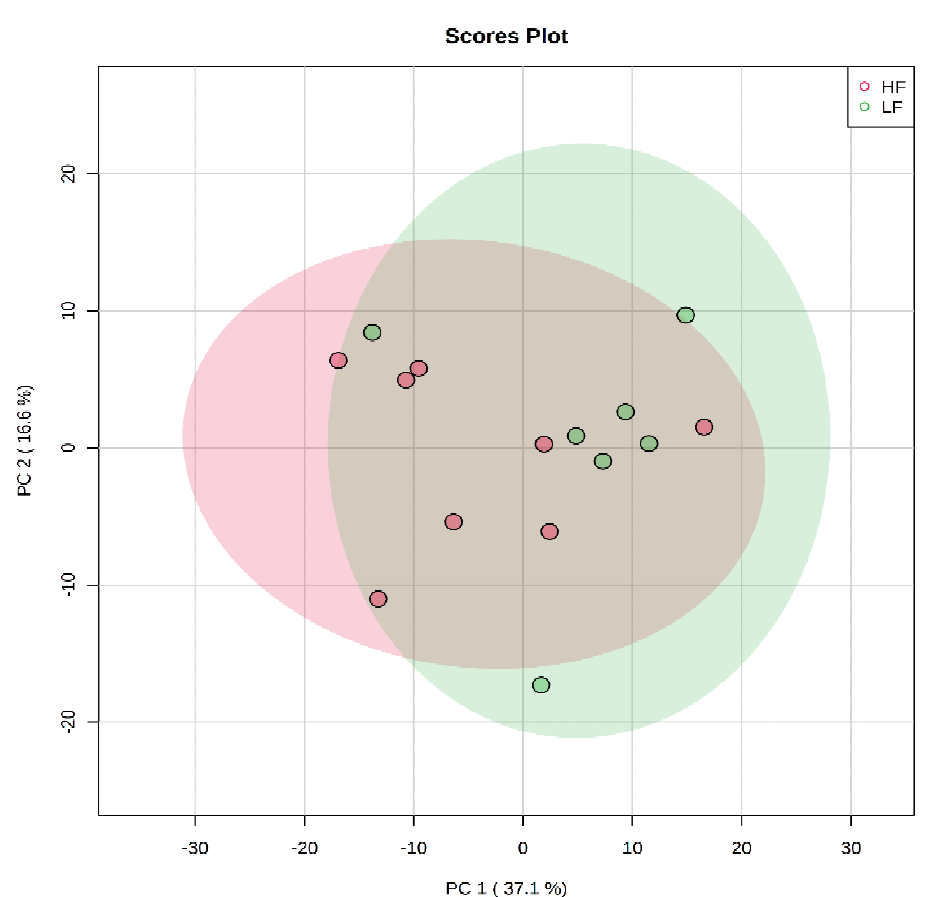
Animals 2021 , 11 , x Figure 1. Principal component analysis scores plot of carboxyl-metabolome of LF and HF steers. LF = beef steers with lowest average daily gain; HF = beef steers with highest average daily gain. Table 1. Differentially abundant plasma carboxylic-acid-containing metabolites between LF and HF steers.